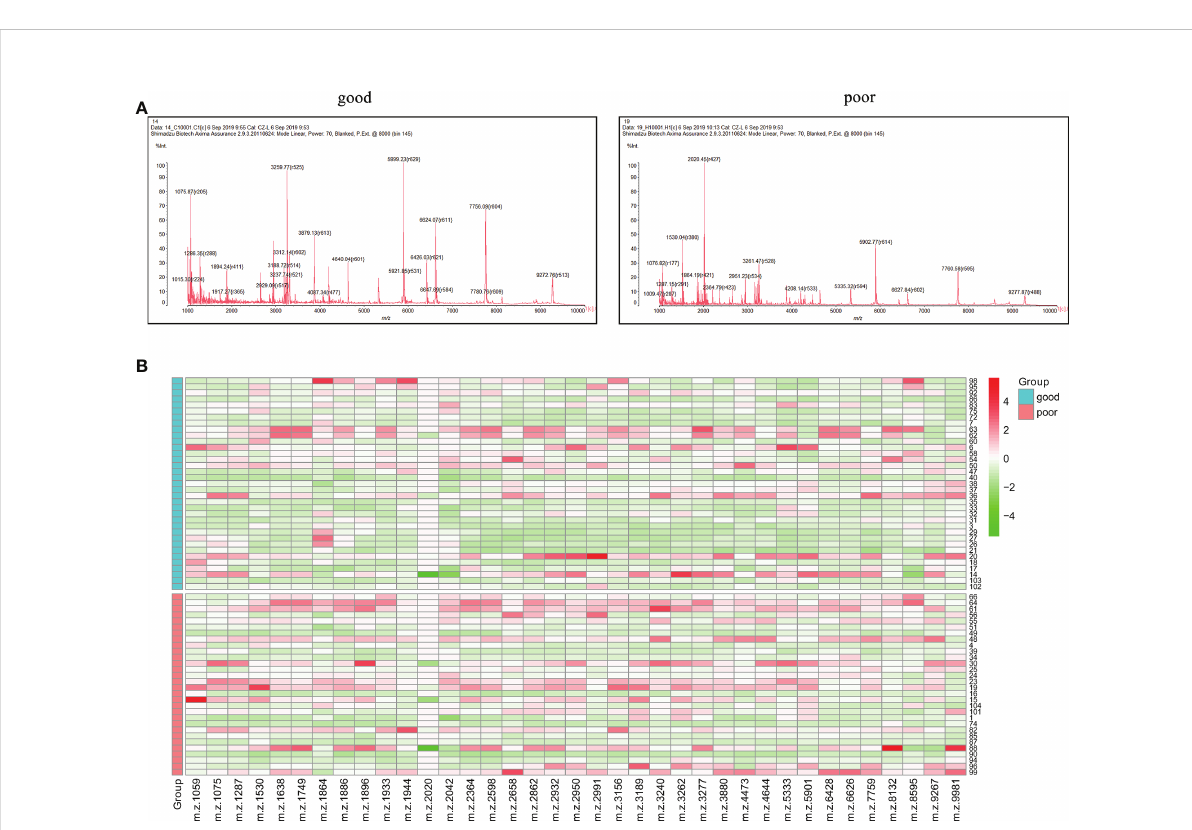
FIGURE 3 Serum peptide patterns in patients with GTN (A) , MALDI-TOF spectra of the serum samples from patients with good or poor outcome; (B) , heatmap of the intensity distribution of the 37 peptide peaks for all